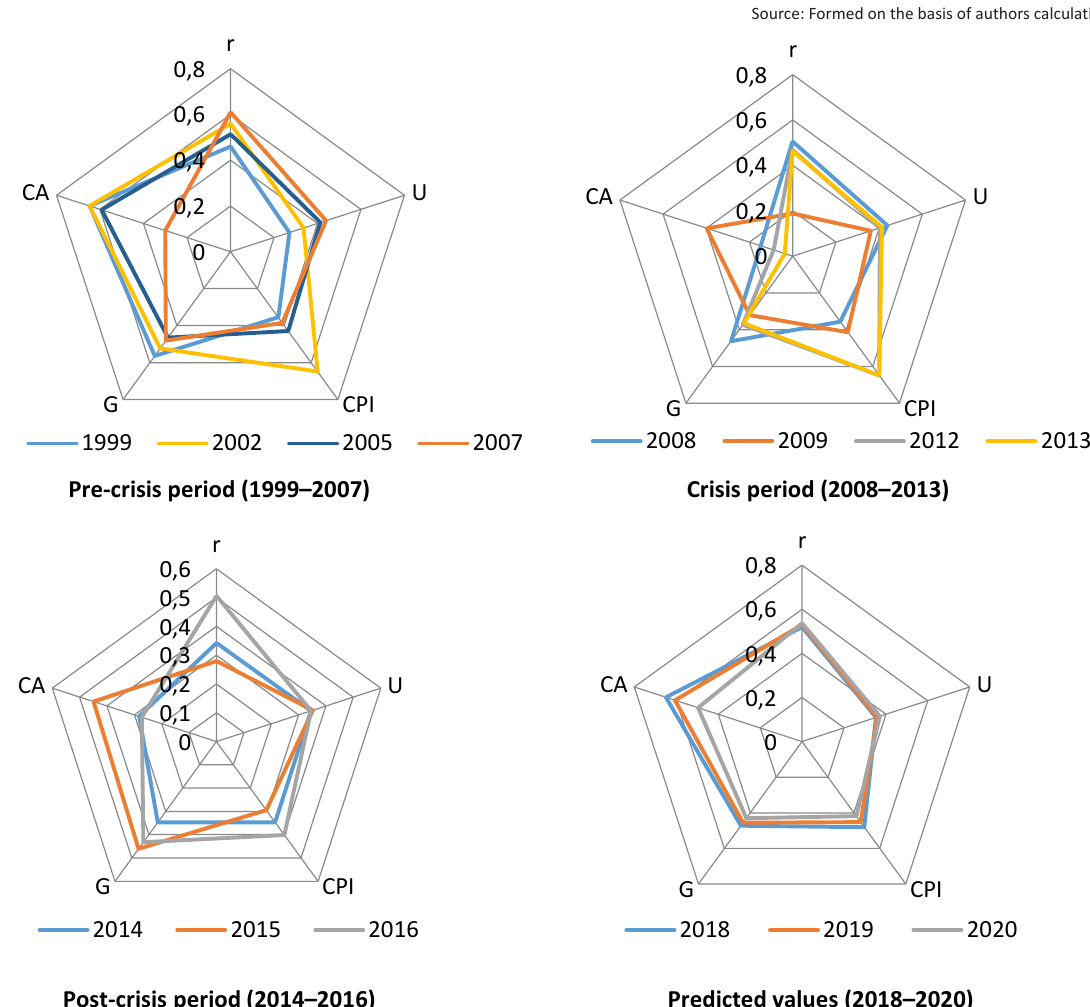
Figure 5. Comparison of MSP profiles in Ukraine at different stages of the economic cycle